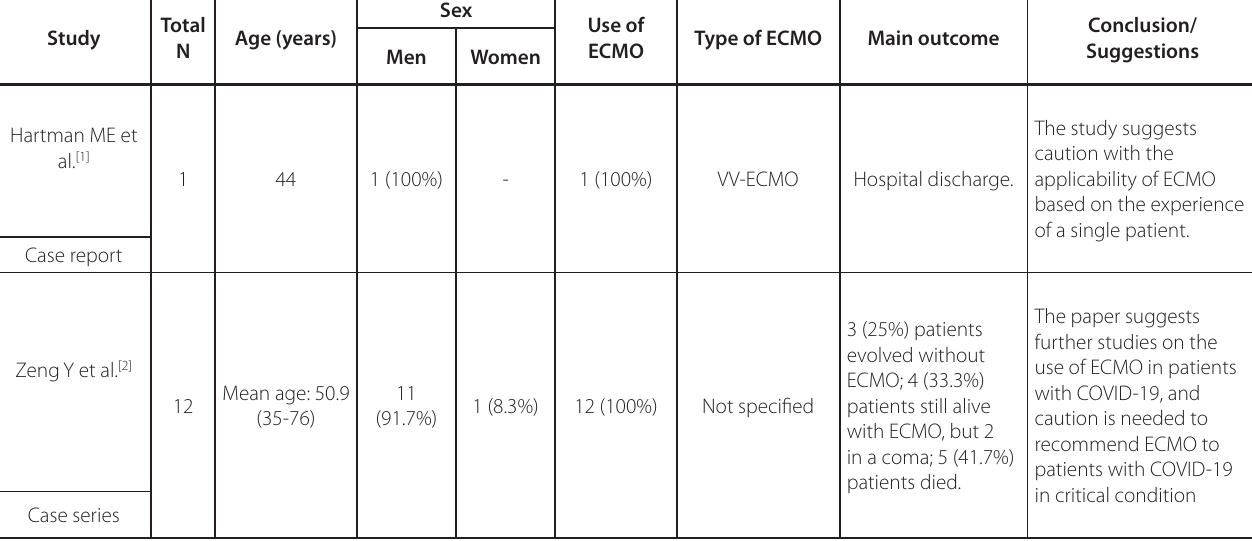
Table 1 . Characterization of the articles included in the study (n=18),